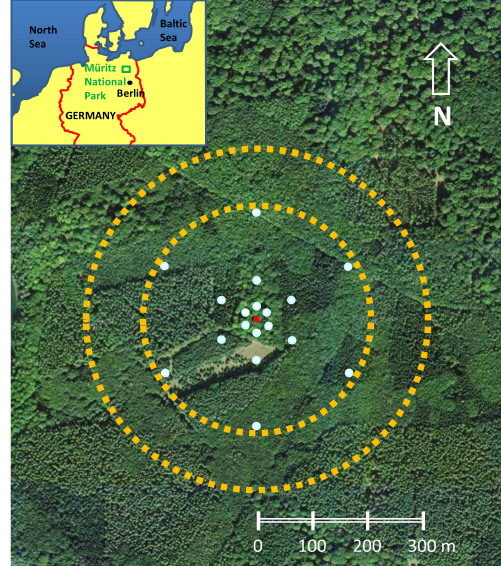
Figure 1. Soil sampling locations for calibration (white dots) and forest vegetation around the CRS (red dot in the center). The TDT soil moisture sensors are located in close vicinity to the sampling locations. The larger yellow circle approximates the footprint of the CRS as it was assumed when sampling took place (diameter approximately 300m). The smaller yellow circle approximates the footprint of the CRS according to newer modeling results by Köhli et al. (2015) (diameter approximately 200m). Inset: field site loca- tion in Müritz National Park in north-eastern Germany.